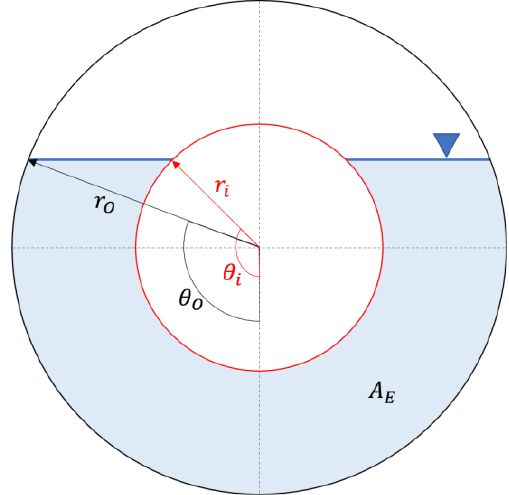
Figure 2. Required parameters to define the effective area.